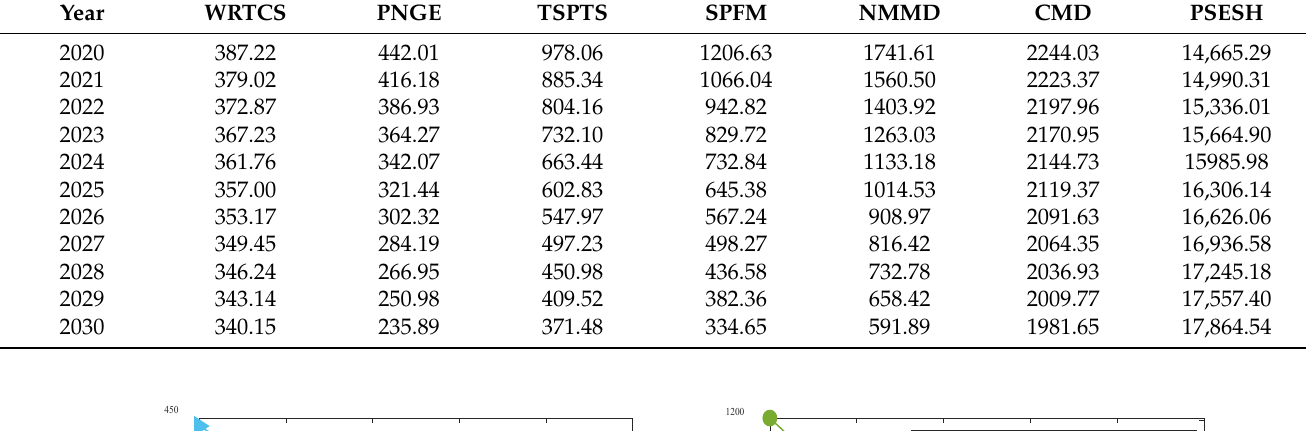
Table 9. Forecasted CO 2 emissions of 7 industries in Shaanxi (million tons).